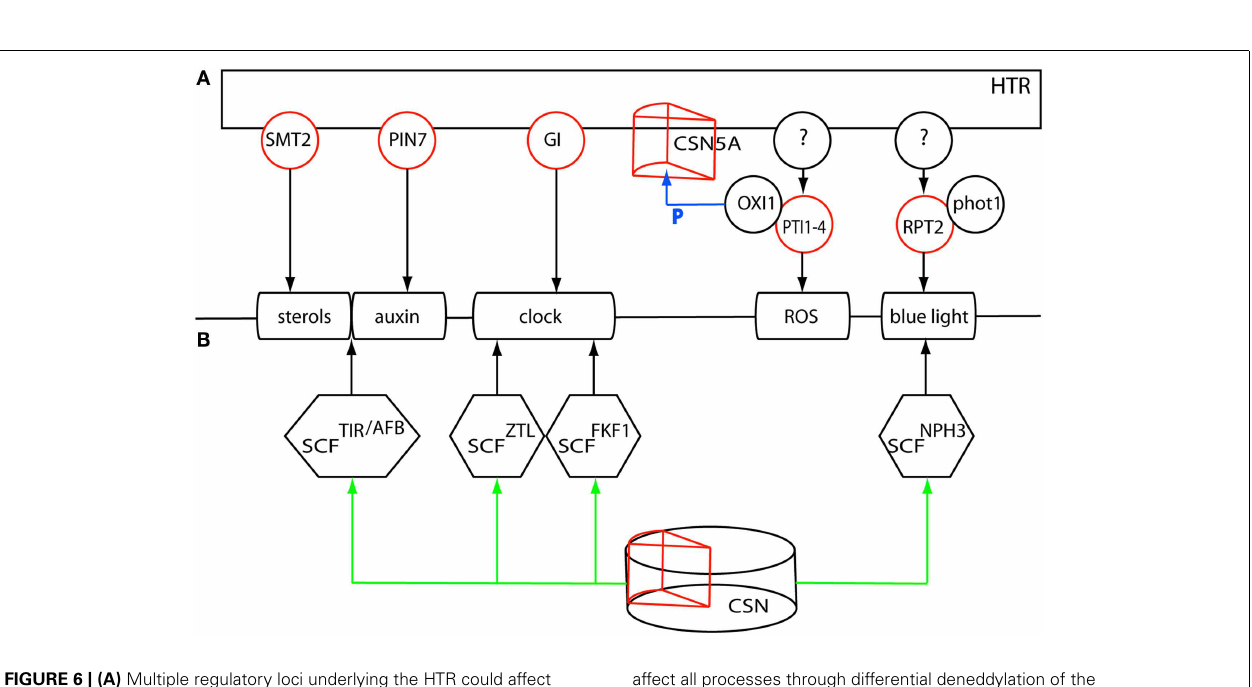
FIGURE 5 | Genomic distributions of eQTLs of the genes with differentially abundant transcripts between LCN1-10 and L er . Bars represent the number of local ( in cis ; purple) and distant ( in trans ; blue) eQTLs